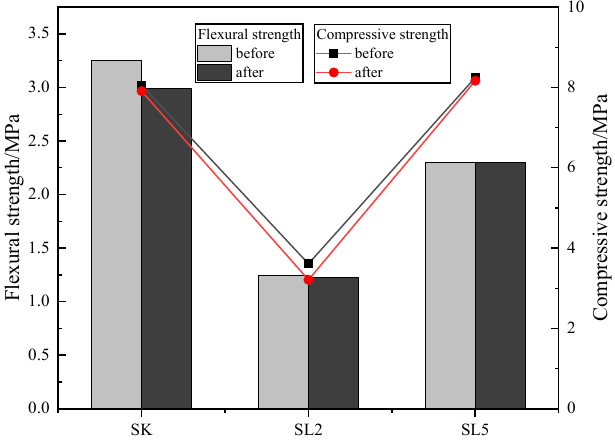
Figure 13. Strength comparison in frost–thaw cycle .